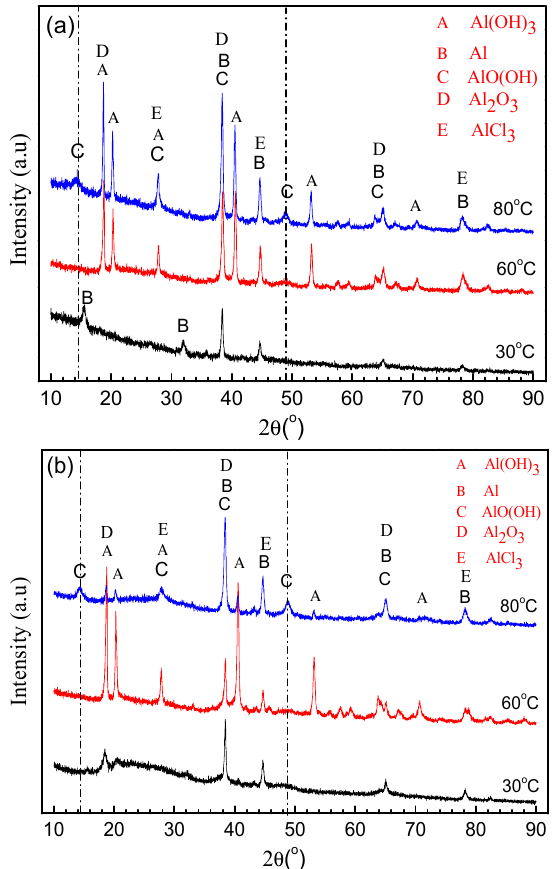
Figure 10. XRD patterns of the corrosion products formed on the surface of 2A02 Al alloy under 4 ± 0.2 mg/cm 2 solid NaCl deposit in 98 ± 2% humidity, at 30 °C, 60 °C, and 80 °C: ( a ) corrosion for 72 h and ( b ) corrosion for 200 h.